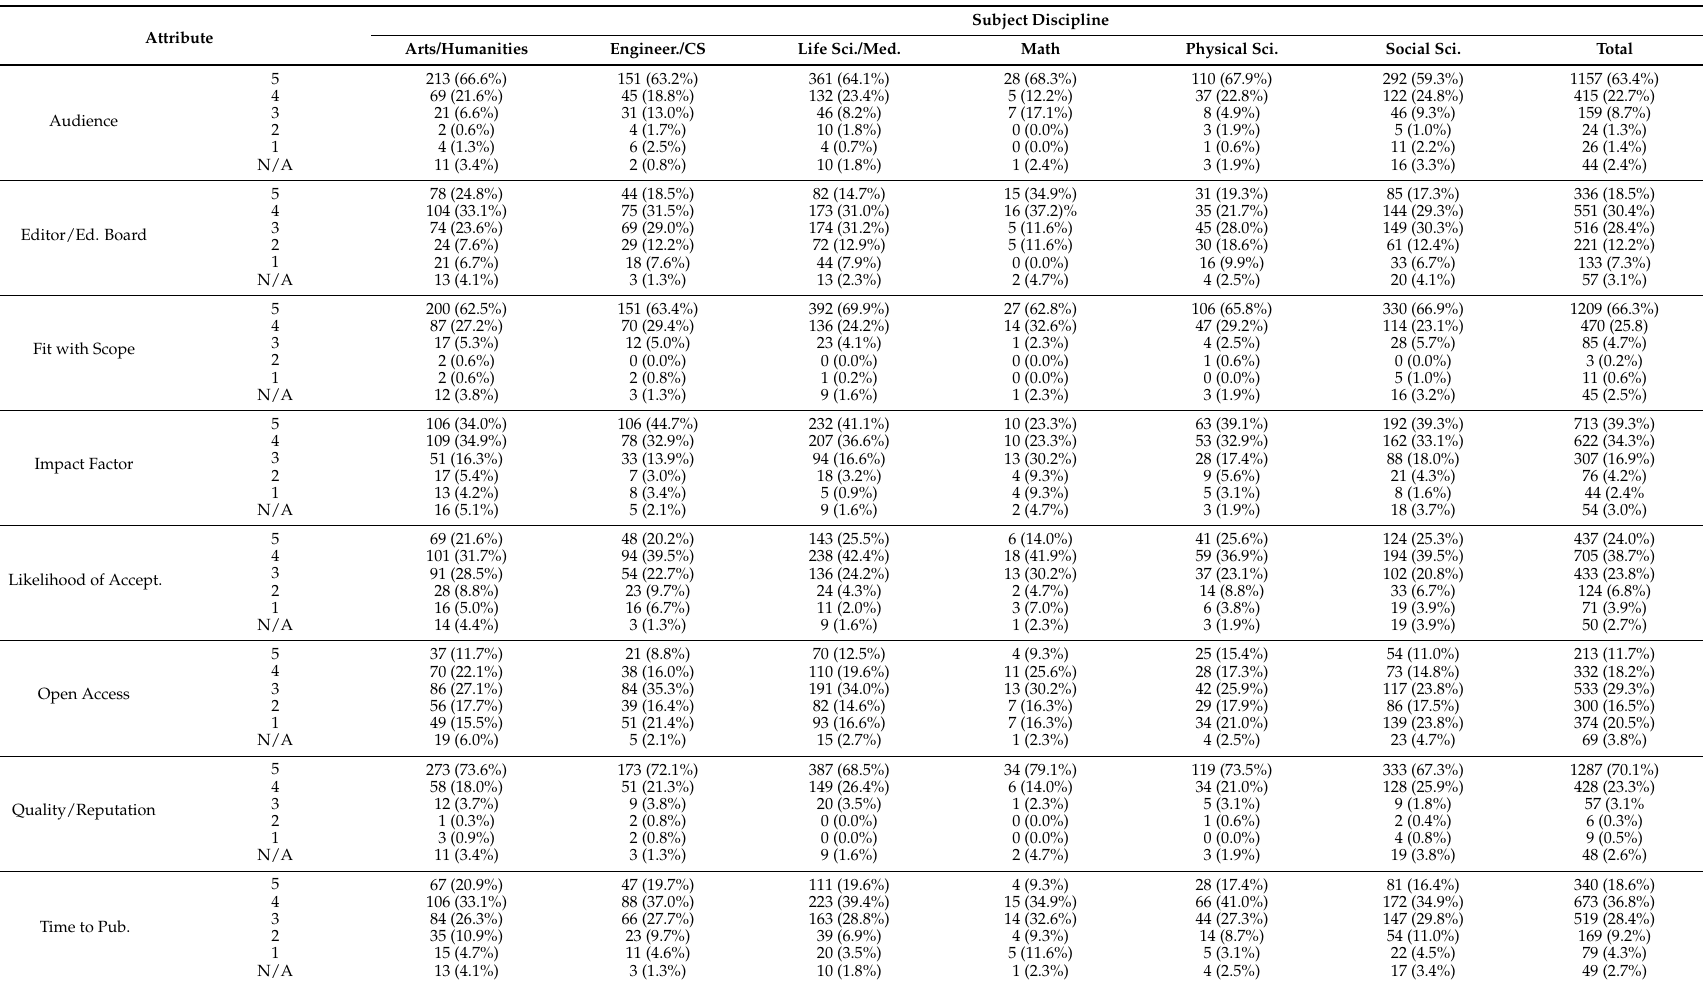
Table 9. Journal attribute importance: percentage by subject